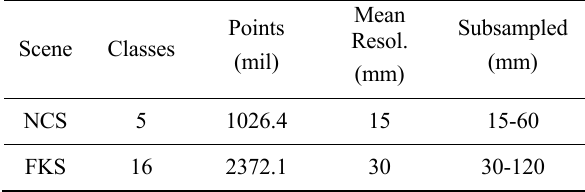
Table 1. Summary of 3d data acquisition and